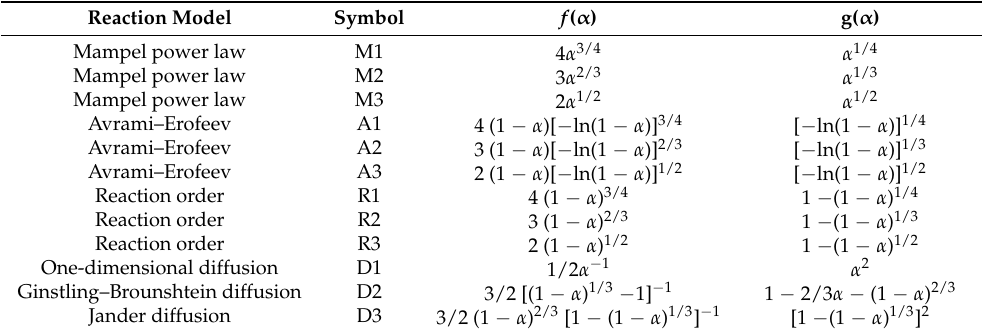
Table 4. Set of alternate reaction models applied to describe the reaction kinetics in heterogeneous solid-state